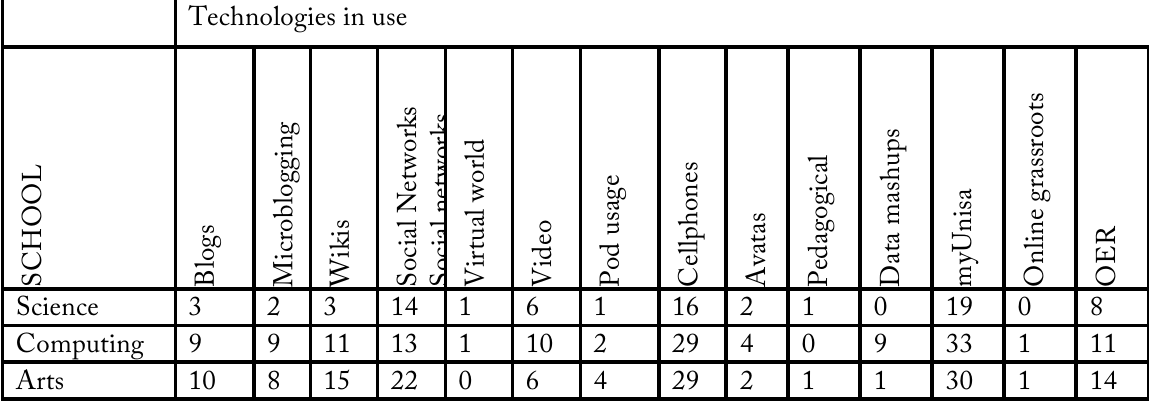
Table 6: Technologies in use by different respondents in the different Schools Technologies in use